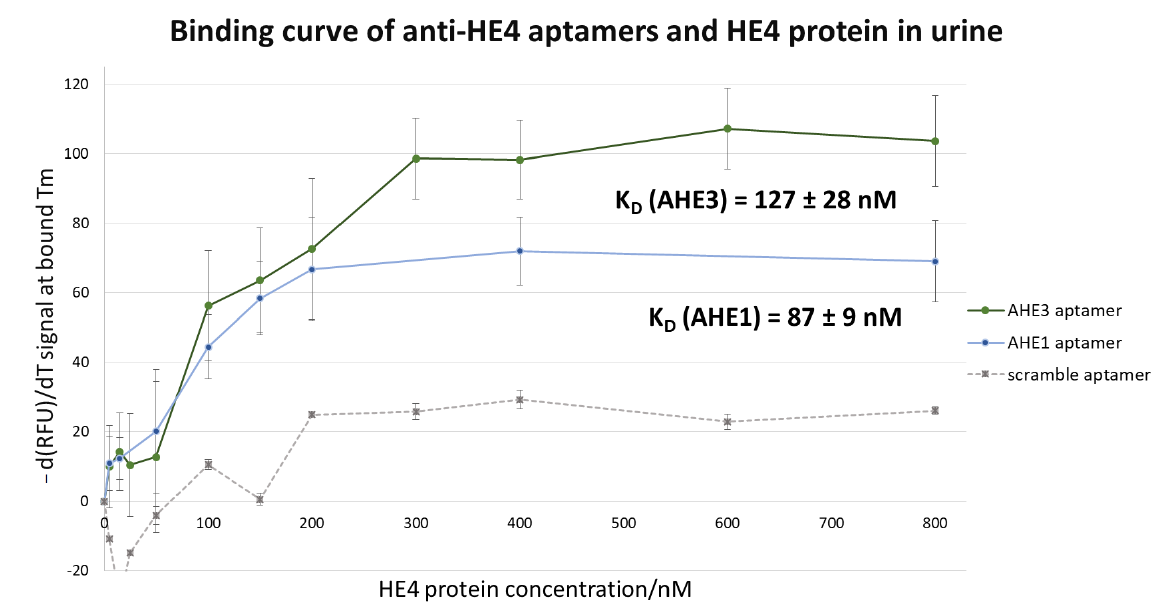
Figure 7. Binding curve of anti-HE4 aptamers to ovarian cancer biomarker HE4 in 1/125 urine. The binding curve was constructed by plotting HE4 protein concentration with negative derivative fluorescence signal − d(RFU)/dT at the T m corresponding to bound aptamer state. The non-linear regression model was used to calculate K d value, showing good affinity in nanomolar range of anti-HE4 aptamers for HE4 in urine, with K d (AHE1) = 87 ± 9 nM and K d (AHE3) aptamer of 127 ± 28 nM. The results showed the average of the minimum 3 independent experiments. The results suggest that the described aptamers could have diagnostic potential as detection probes for HE4 in urine tests for ovarian cancer.